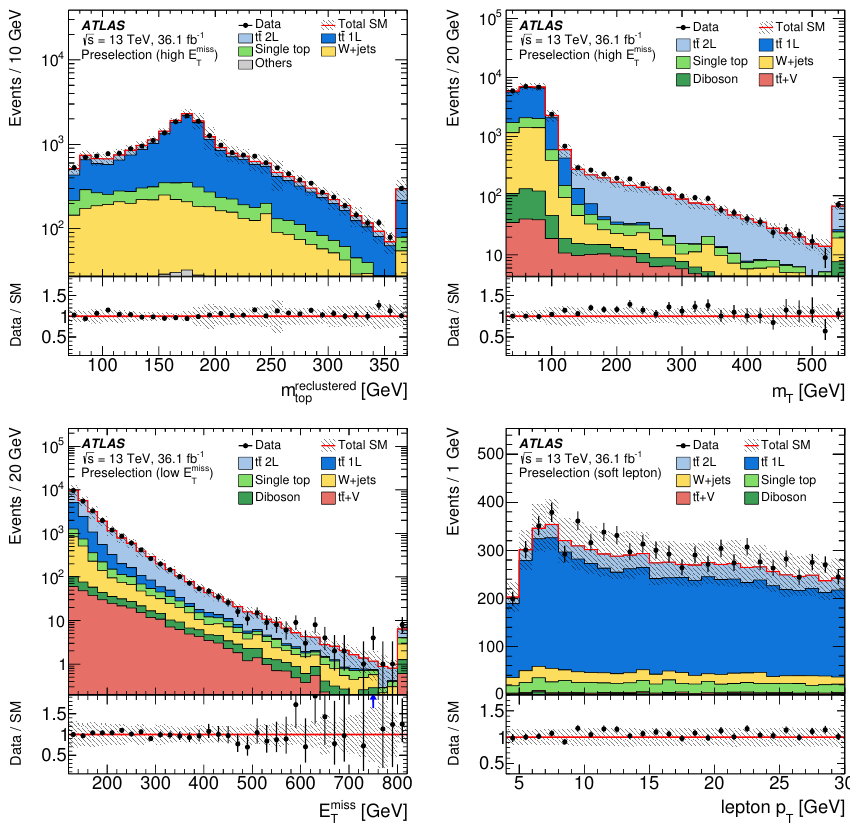
Figure 8 . Kinematic distributions after the preselection: (top left) mass of the hadronic top-quark candidate with the recursive reclustering method ( m reclustered ) after the high- E miss preselection, (top top T right) m T after the high- E miss preselection, (bottom left) E miss after the low- E miss preselection, T T T and (bottom right) lepton p T after the soft-lepton preselection with an additional requirement of at least two b -tagged jets. The SM background predictions are normalised with the theoretical cross-sections (pre-(cid:12)t), except for in the E miss distribution, where the t (cid:22) t events are scaled by the T normalisation factors obtained from a simultaneous likelihood (cid:12)t of the CRs. The category labelled ‘Others’ in the top left panel stands for the sum of minor SM backgrounds that contribute less than 5% of the total SM background. The hatched area around the total SM prediction and the hatched band in the Data/SM ratio include statistical and experimental uncertainties. The last bin contains over(cid:13)ows, except for the lepton p T distribution.